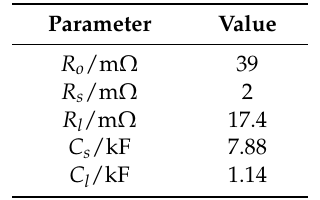
Table 3. Parameter identification